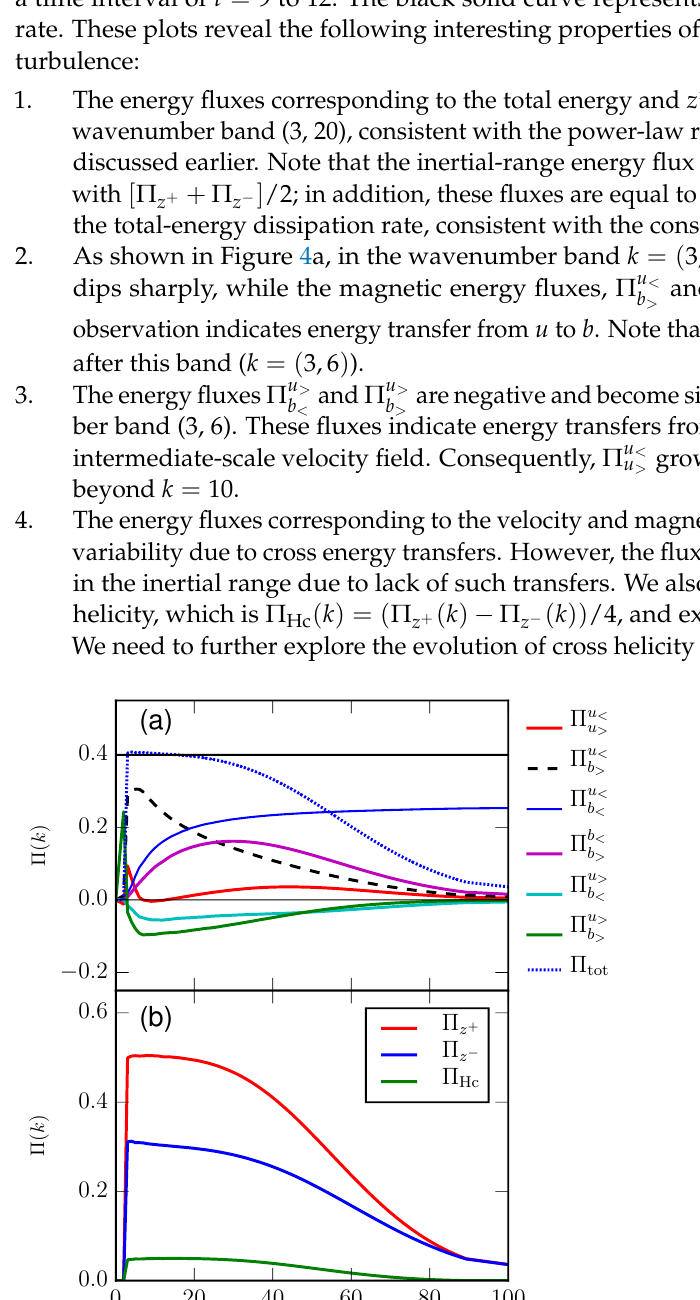
, Π u < , Π u > , Π u < , Π b < , Π u > and Π total , b > b < b < b > b > > 12. Note, the solid black curve shows −